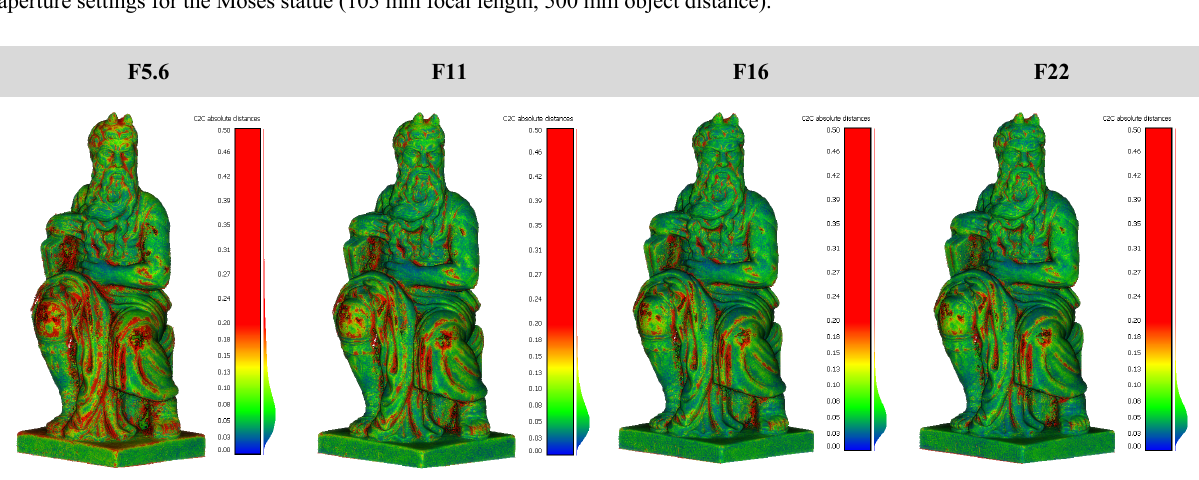
Figure 2. Cloud-to-Cloud comparison [mm] with F5.6, F11, F16 and F22 for the Moses statue. Range [0.00/0.50 mm]. 3D data derived from images acquired with a higher F-number present fewer discrepancies from the ground-truth data.